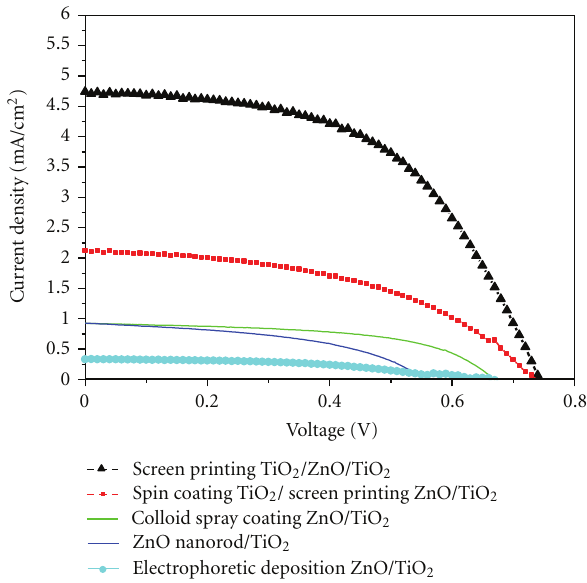
Figure 7: IV curve of DSSC based on ZnO/TiO 2 composite film.